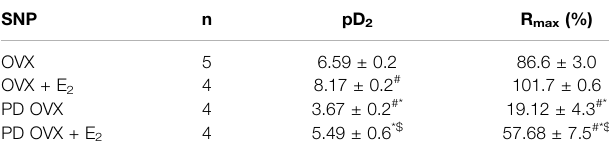
TABLE 3 | Sensitivity (pD 2 : logEC 50 ), and Maximum Response (R max ) to sodium nitroprusside (SNP) in intact rat mesenteric arterial rings from ovariectomized (OVX) and E 2 replaced (OVX + E 2 ) control and prediabetic (PD) rats.